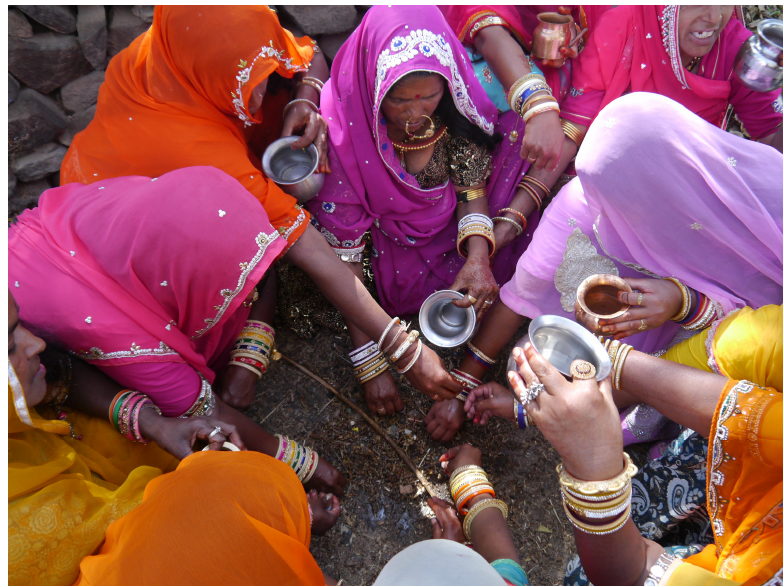
Figure3 Figure 3. Women caring for mother soil by gift-giving—photo by Notermans, March